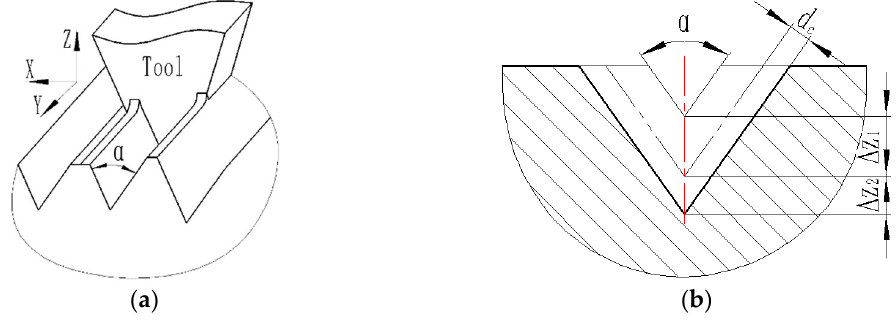
Figure 5. Stepped cutting in the Z-axis: ( a ) V-groove cutting schematic diagram, ( b ) Stepper deep feed.